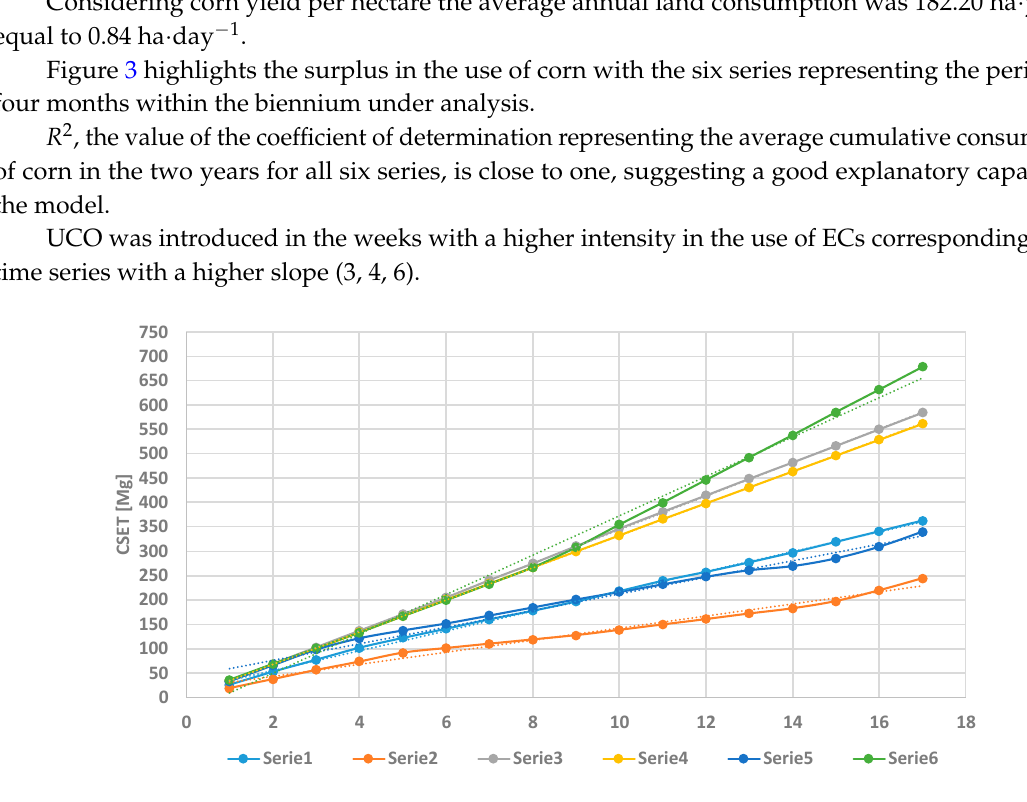
Figure 3. Cumulative distribution function of the corn used in the biennium 2013–2014.